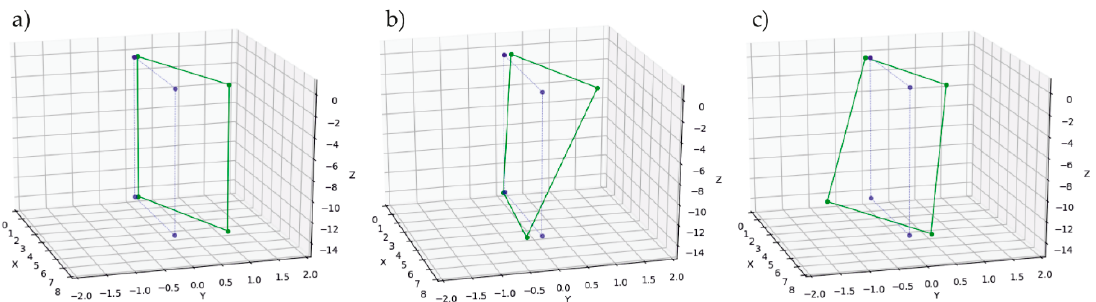
Figure 14. Identified in the eigensystem realization algorithm (ERA) eigenforms. ( a ) 1st; ( b ) 2nd; ( c ) 3rd. Blue points indicate the original positions of sensors. Green marked points displaced according to identified eigenform shape.